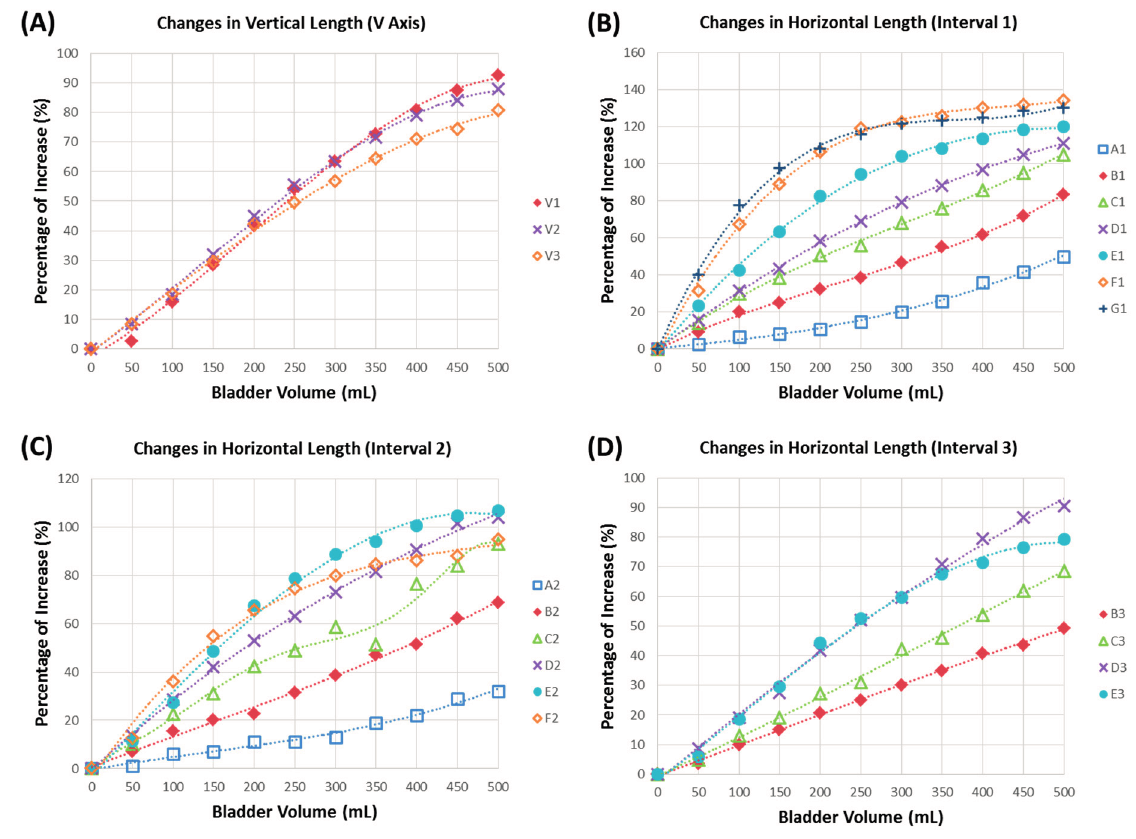
Figure 5. Results of the geometric relationship between the bladder capacity and normalized bladder wall length in the vertical and horizontal directions, including ( A ) the vertical length (axis V), ( B ) Interval 1, ( C ) Interval 2 and ( D ) Interval 3 for all horizontal axes. The percentage of increase represents the increased bladder wall length normalized relative to its original length. All data were further plotted using a polynomial (third-order) curve fitting with R 2 -values of at least